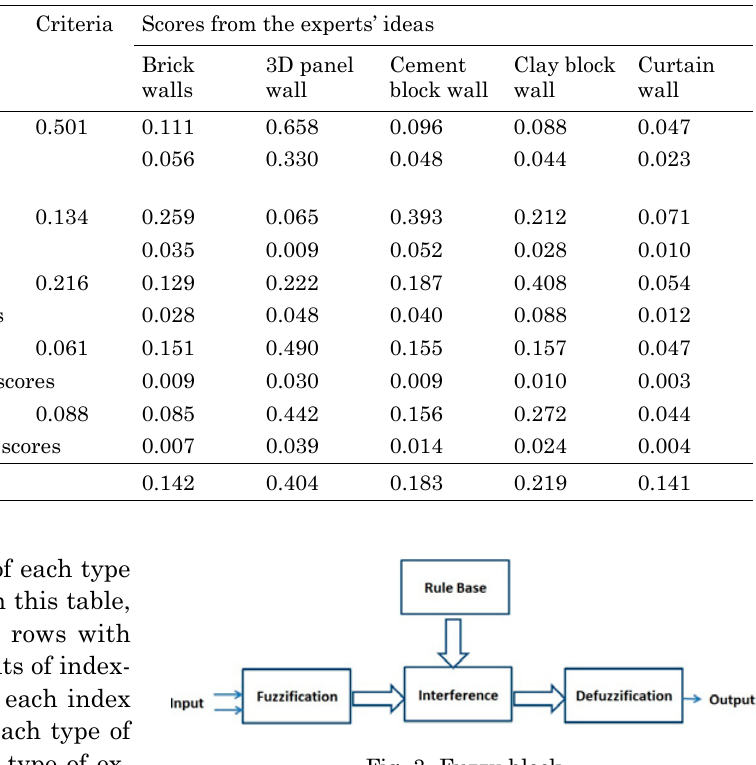
Table 10. final weight of each type of exterior walls